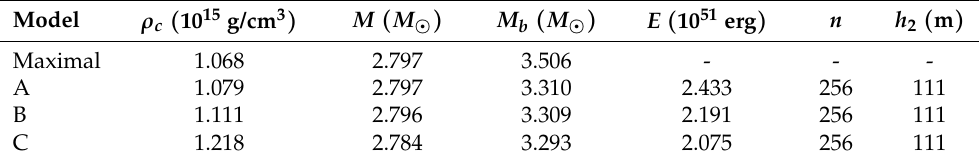
Table 1. Properties of the TOV stars. From left to right, the columns read: model name, central rest-mass density, gravitational mass, baryonic mass, emitted neutrino energy (up to the collapse for those evolved with NLS), grid resolution, and distance between grid points on the finest level. The central densities for this test were chosen to meet the same initial conditions of [73]. The top row, ‘Maximal’, refers to the model at the onset of